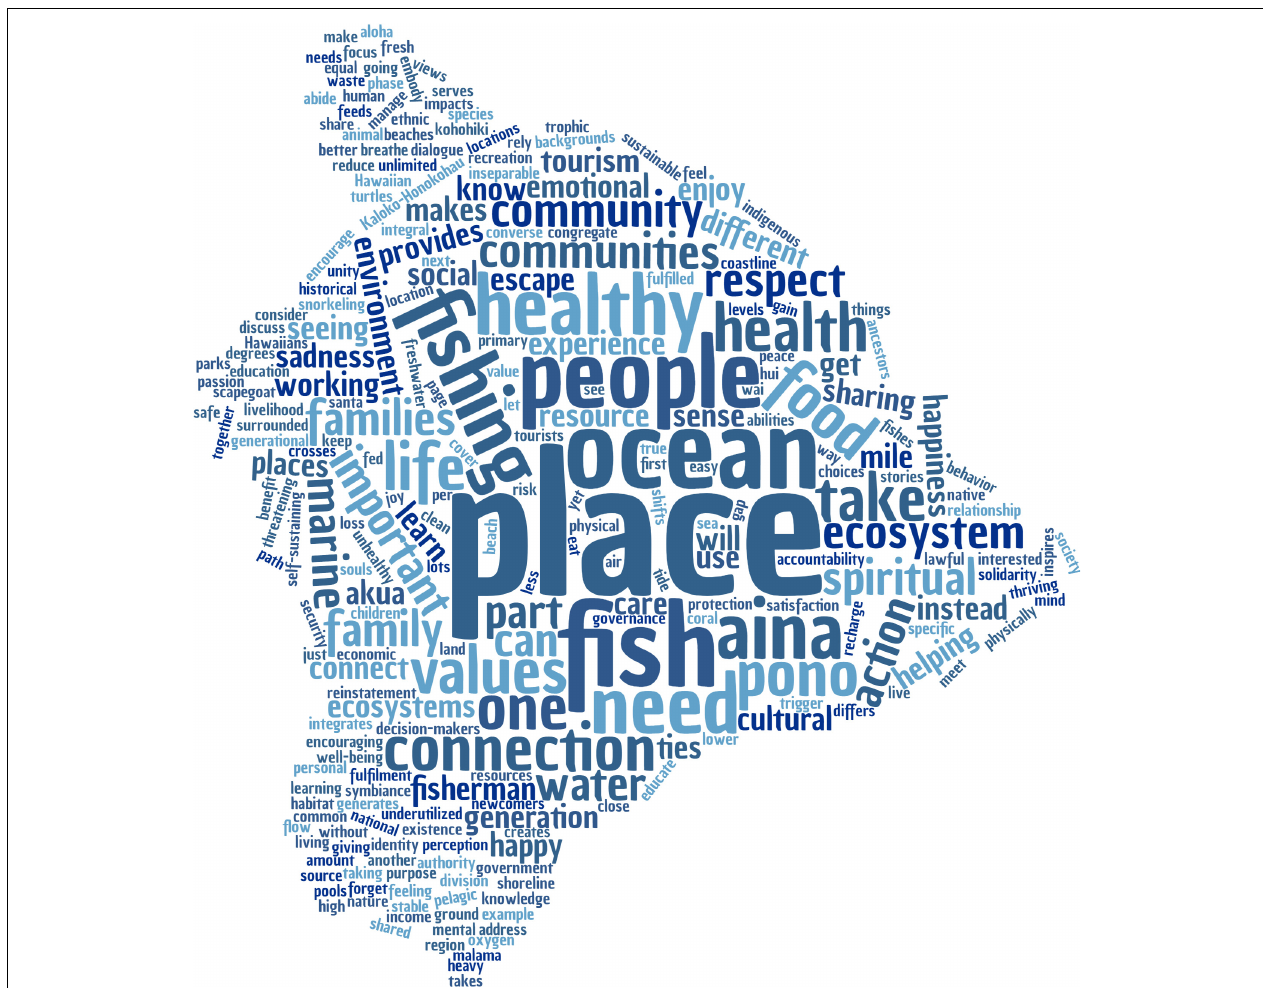
FIGURE 2 | Word cloud of compiled responses from all participant responses to the question “How does the marine ecosystem contribute to the things that matter most to the people in West Hawai‘i?” All responses included are verbatim. Word size relates to frequency of word